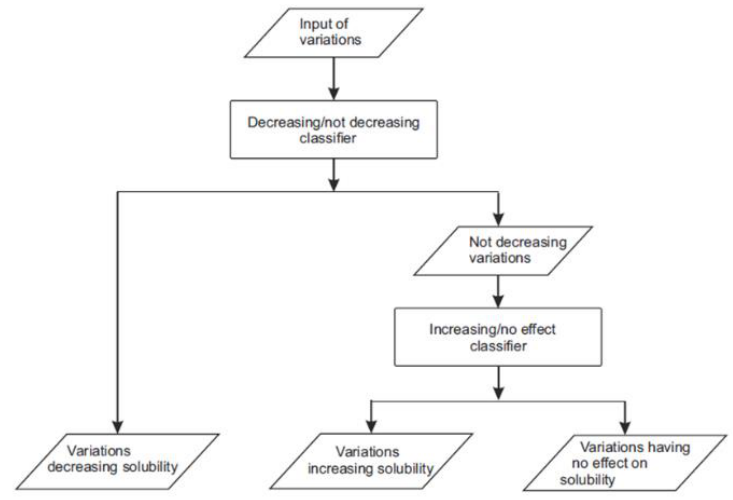
Figure 1. Scheme for two-layer three-class classifier.